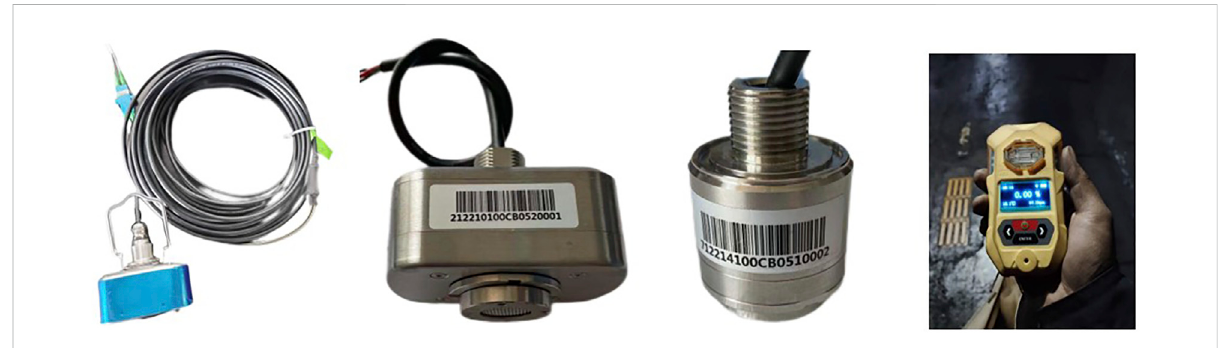
FIGURE 2 The developed laser methane sensor products.